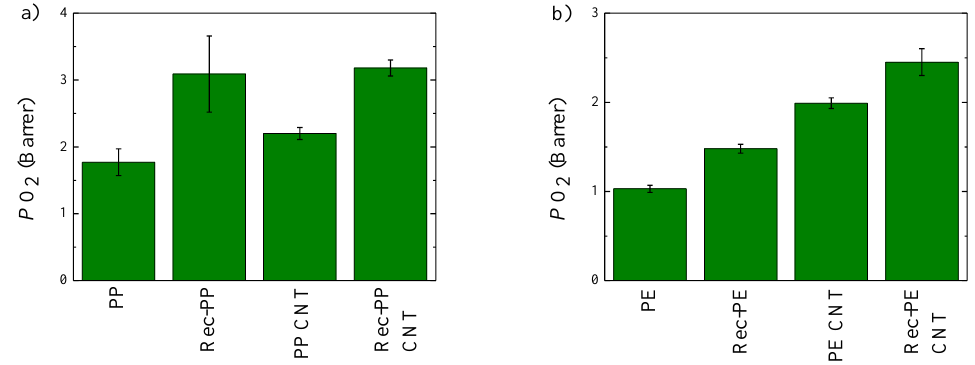
Figure 8. Oxygen permeability for: ( a ) Systems based on PE and ( b ) systems based on PP.